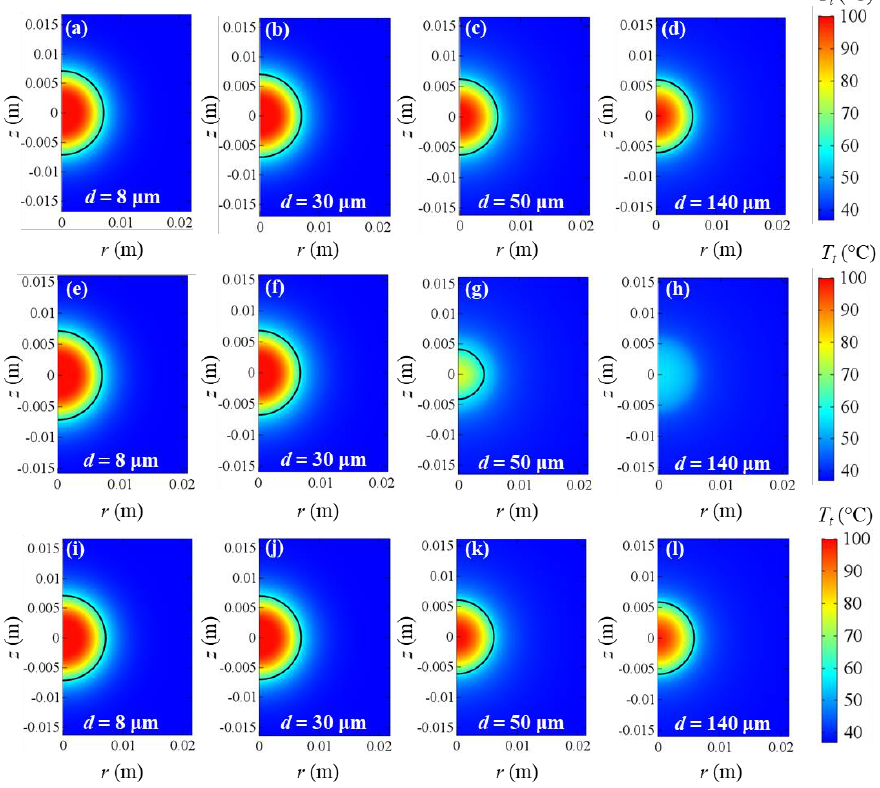
Figure 7. Tissue temperature fields at the end of heating time for uniform ε = 0.07 ( a – d ), uniform ε ε = 0.23 ( e – h ), and ε var ( i – l ). Capillaries ( d = 8 µ m), terminal arteries ( d = 30 µ m), terminal branches = 0.23 ( e – h ), and εvar ( i – l ). Capillaries ( d = 8 μm), terminal arteries ( d = 30 μm), terminal branches ( d = 50 μm), and tertiary branches ( d = 140 μm) are taken into account. Coagulation contours de- ( d = 50 µ m), and tertiary branches ( d = 140 µ m) are taken into account. Coagulation contours limited by the black lines. delimited by the black